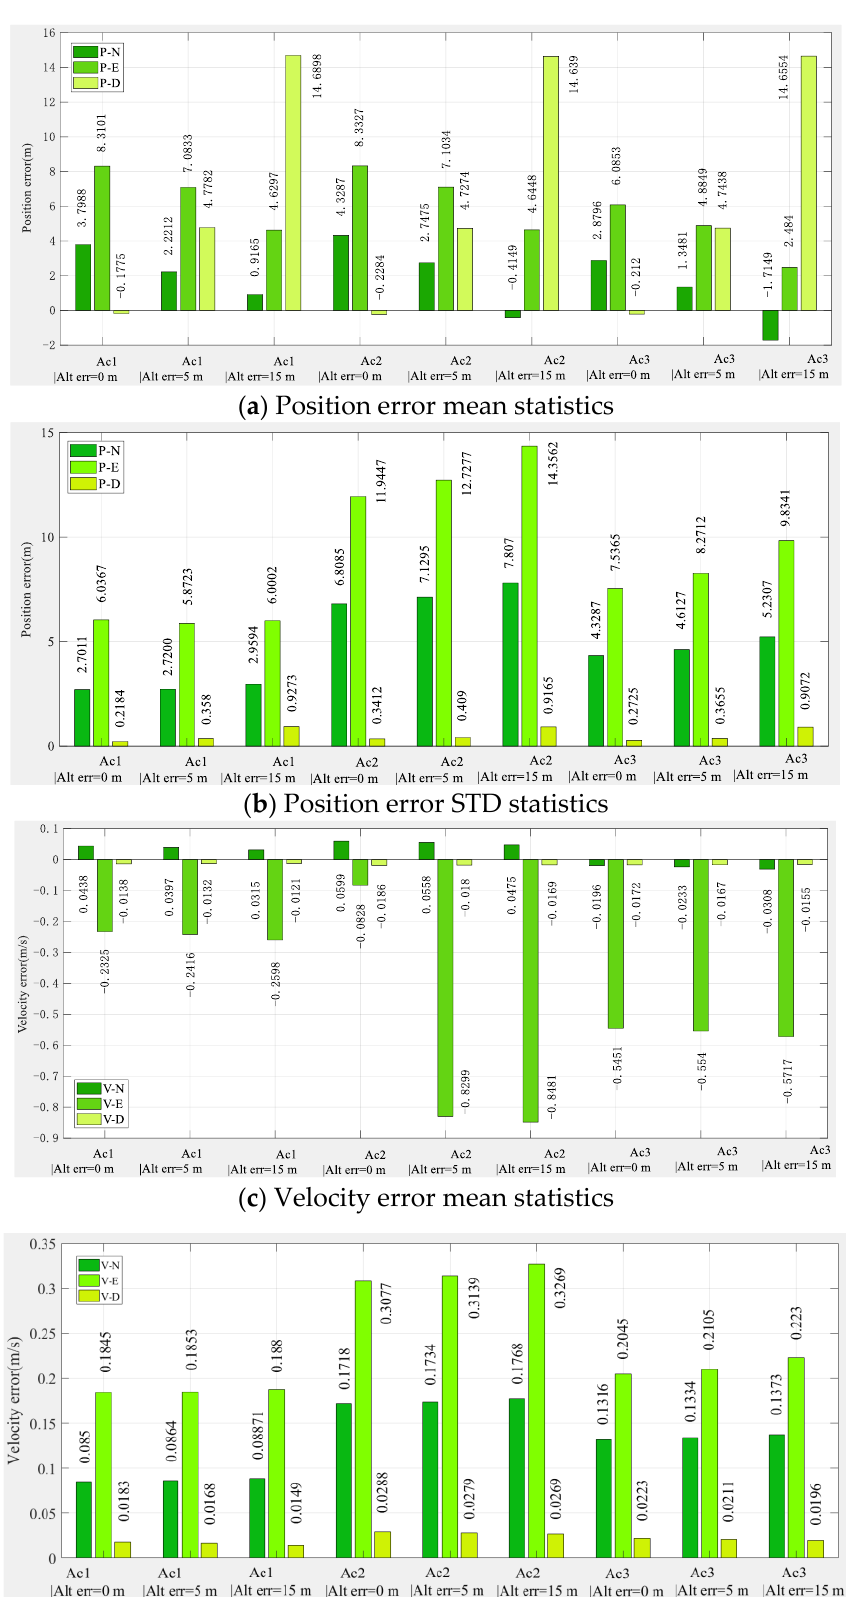
Figure 9. Statistical histogram of the multi-aircraft cooperative navigation and positioning index of the DWAPC-TSM system assisted by an altimeter According to the statistical results and in Figure 9: